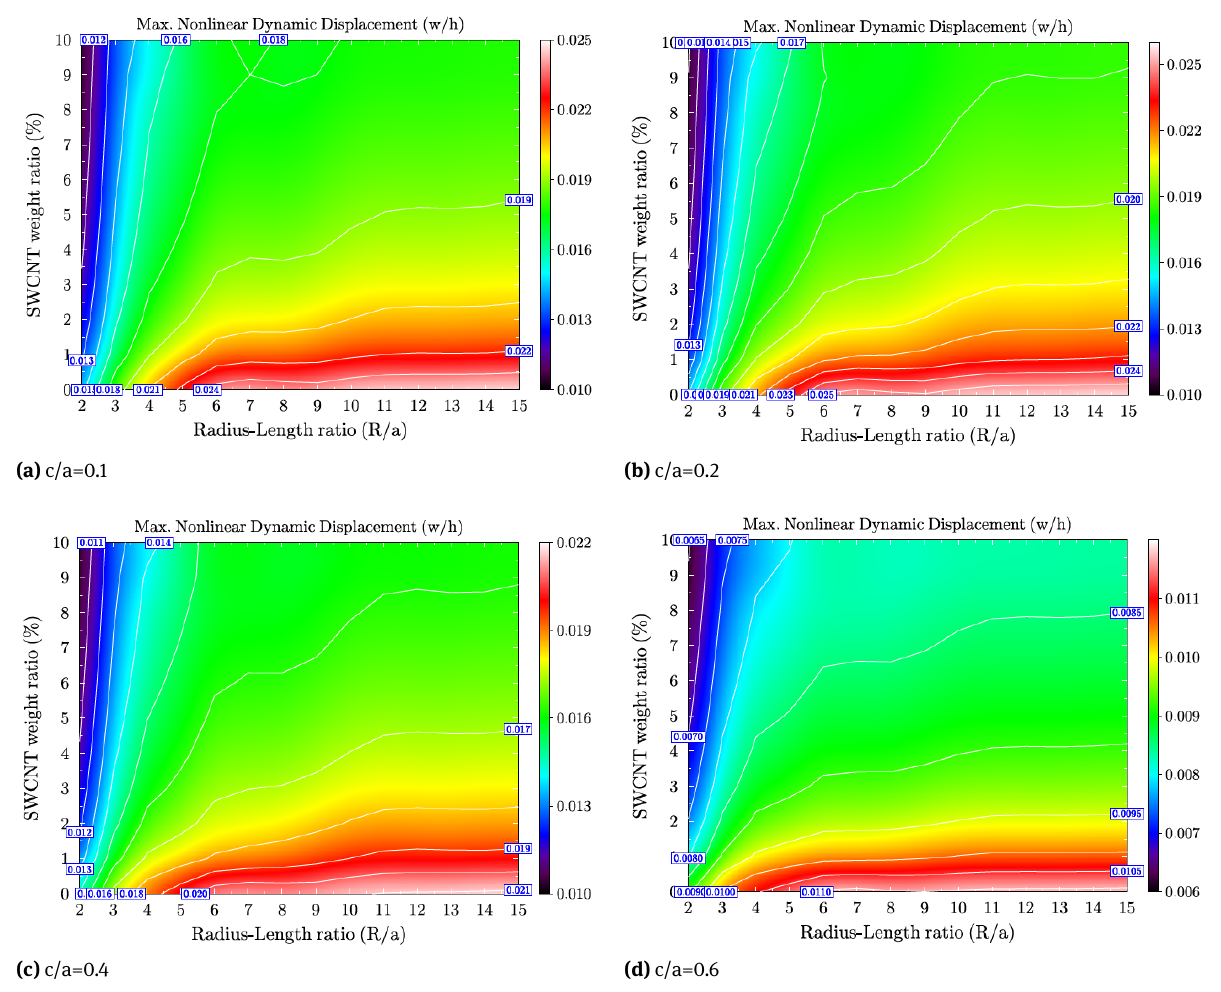
Figure 9: Maximum nonlinear dynamic displacements of [45/ − 45/45/ − 45] CNTFPC spherical shells for increased cutout sizes and SWCNT weight ratios, and radius-length